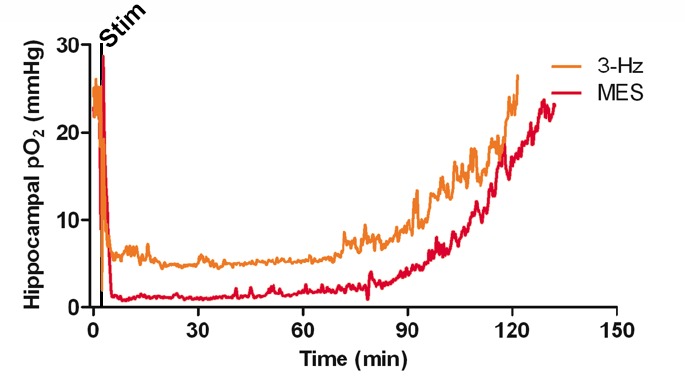
Postictal severe hypoxia generalizes to other seizure models.Both stimulations resulted in severe hypoxia. A 40 s seizure was elicited with MES stimulation and resulted in 104.1 min of severe hypoxia (red). Following 2 min of 3 Hz stimulation, hippocampal pO2 dropped below 10 mmHg for 90.4 min (orange).